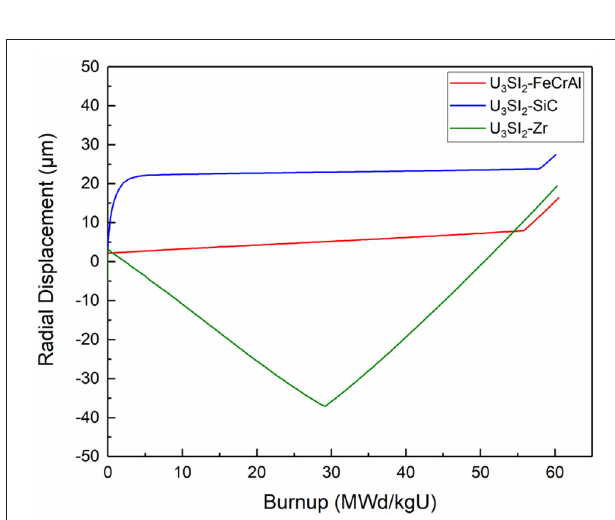
FIGURE 11 | Radial displacement at inner cladding surface of three types of